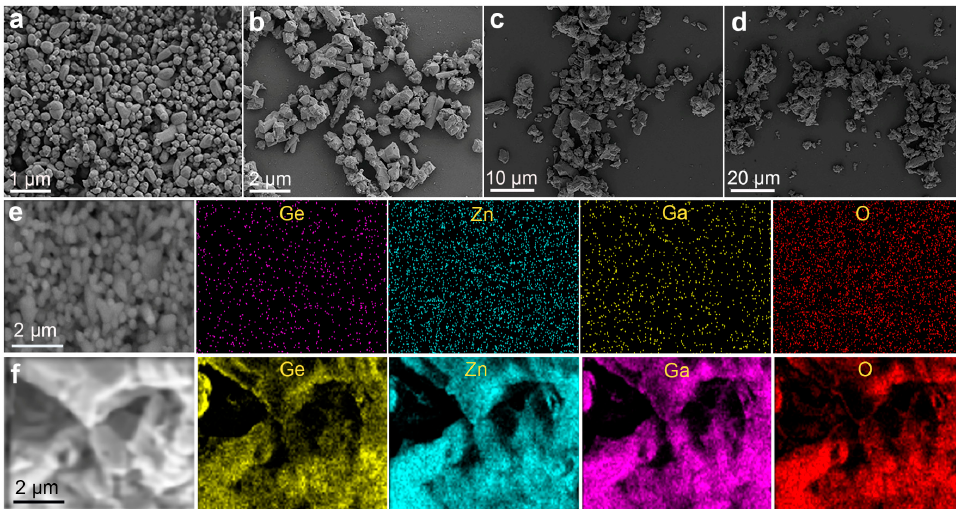
Figure 2. SEM images ( a – d ) and EDX mapping ( e , f ) of Zn 3 Ga 2 GeO 8 phosphors annealed at 1100 °C. ( a , b ) Zn 3 Li 0.4 Ga 1.6 GeO 8 :Mn phosphor in ( a ) and Zn 2.4 Li 0.6 Ga 2 GeO 8 :Mn in ( b ) synthesized by hydrothermal approach; ( c , d ) Zn 2.4 Li 0.6 Ga 2 GeO 8 :Mn in ( c ) and Zn 3 Ga 2 GeO 8 :Mn in ( d ) synthesized by solid-state reaction; ( e ) EDX mapping of Zn 3 Li 0.4 Ga 1.6 GeO 8 :Mn synthesized by hydrothermal approach; and ( f ) EDX mapping of Zn 3 Ga 2 GeO 8 :Mn synthesized by solid-state reaction.